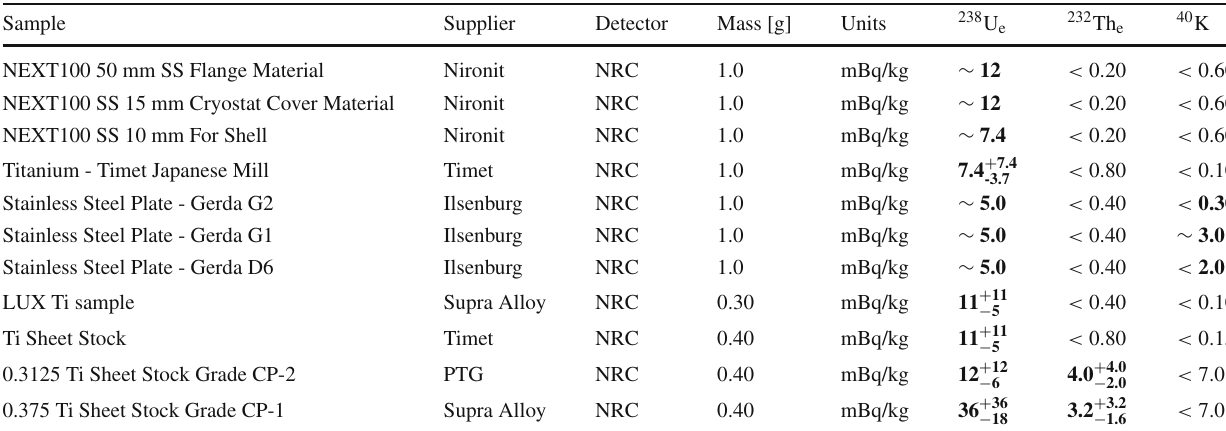
Table 12 GDMS screening